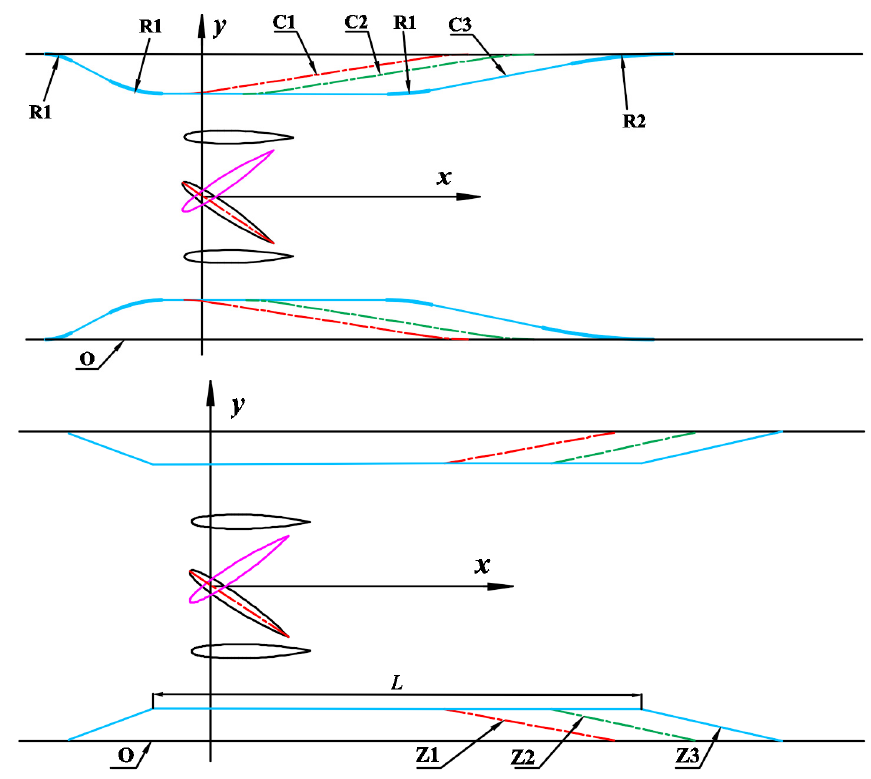
Figure 3. Schematic diagram of different flow passage devices.